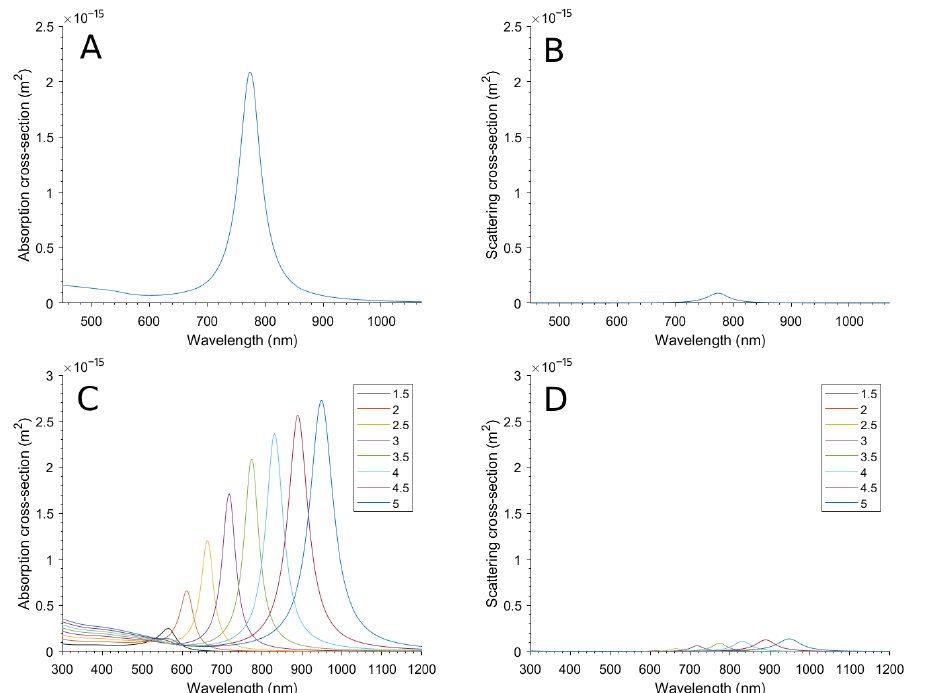
Figure 5. ( A ) Absorption cross-section and ( B ) scattering cross-section of the NanoRod with an aspect ratio fixed to 3.5. ( C ) Absorption cross-section and ( D ) scattering cross-section of the NanoRod when the aspect ratio is varied between 1.5 and